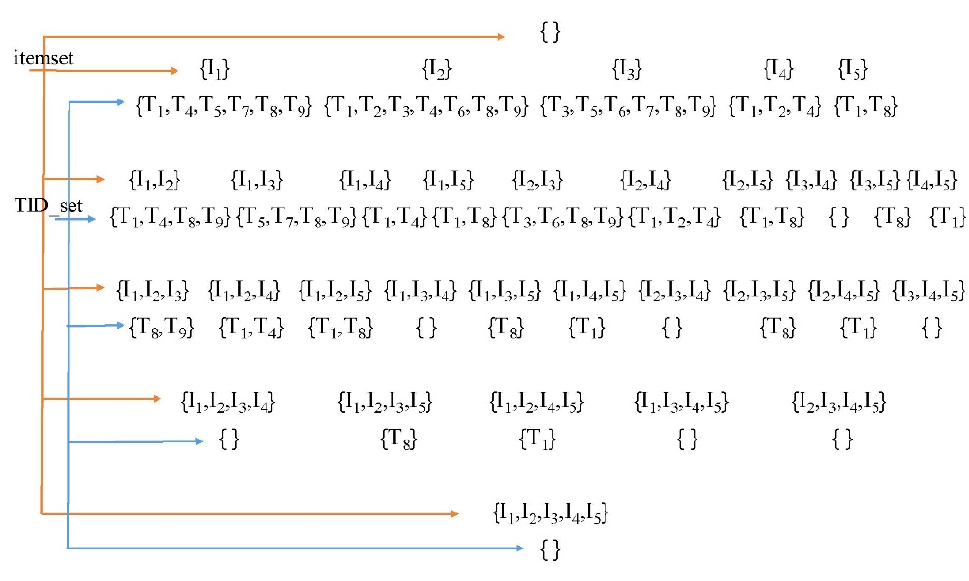
Figure 1. The procedure of Eclat for the example database in Table 1.